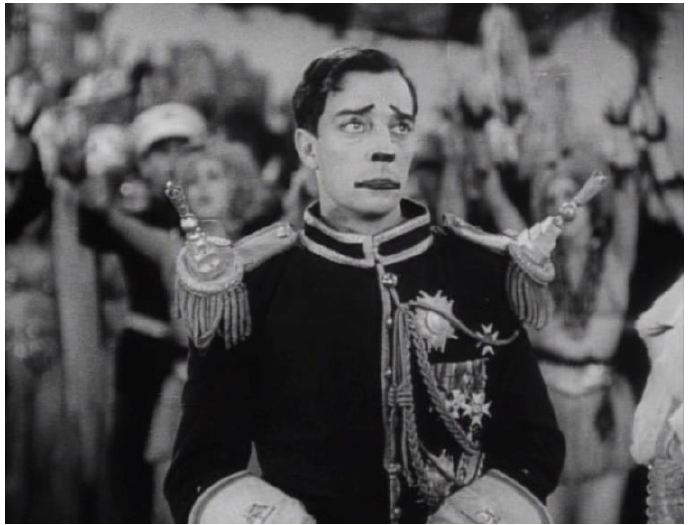
Figure 1. In Free and Easy (Edward Sedgwick, 1930), Elmer (Buster Keaton) must perform comedy in clown-like whiteface even while his heart is